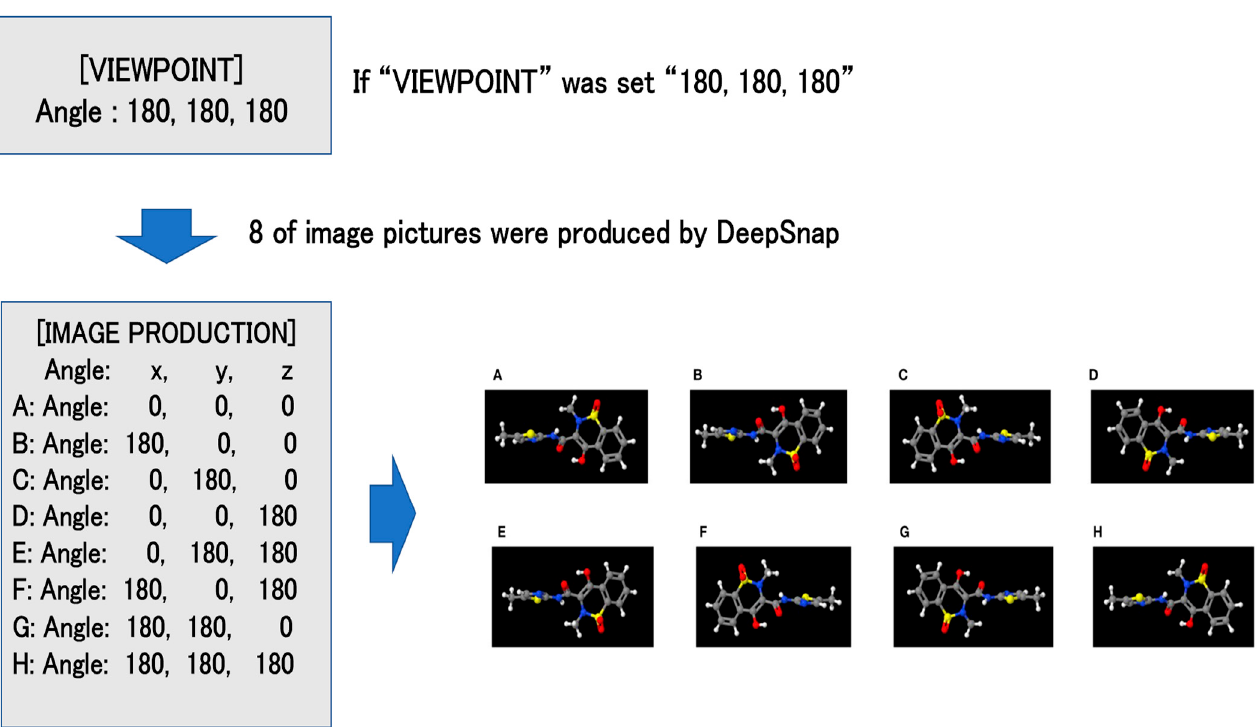
Figure 4. Image production and angle in the Deep Snap. Number of pictures are determined by automatically capturing 3D chemical structure as snapshots at user-defined angles on the x -, y -, and z -axes. Then, it was saved as a PNG file with 256- × 256-pixel resolution for the Deep Learning process. If the view was set as (180, 180,180), eight image pictures ( A – H ) were produced by the Deep Snap.